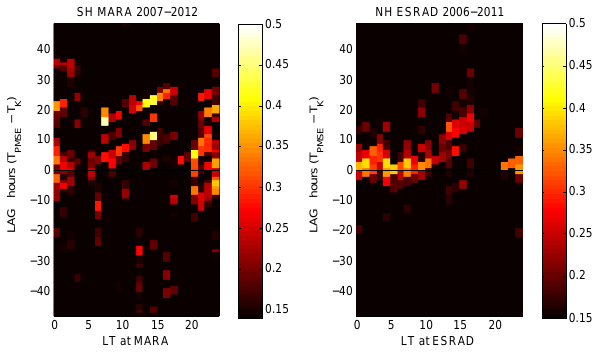
Fig. 4. Cross-correlation coefficients (colour scale) between local K index and PMSE reflectivity (maximum value each hour) as a function of local (solar) time and lag between K index and PMSE reflectivity. A positive lag means PMSE reflectivity increases after an increase in K index. Correlation coefficients are calculated sep- arately for each season, and those with less than 95% significance are set to zero before